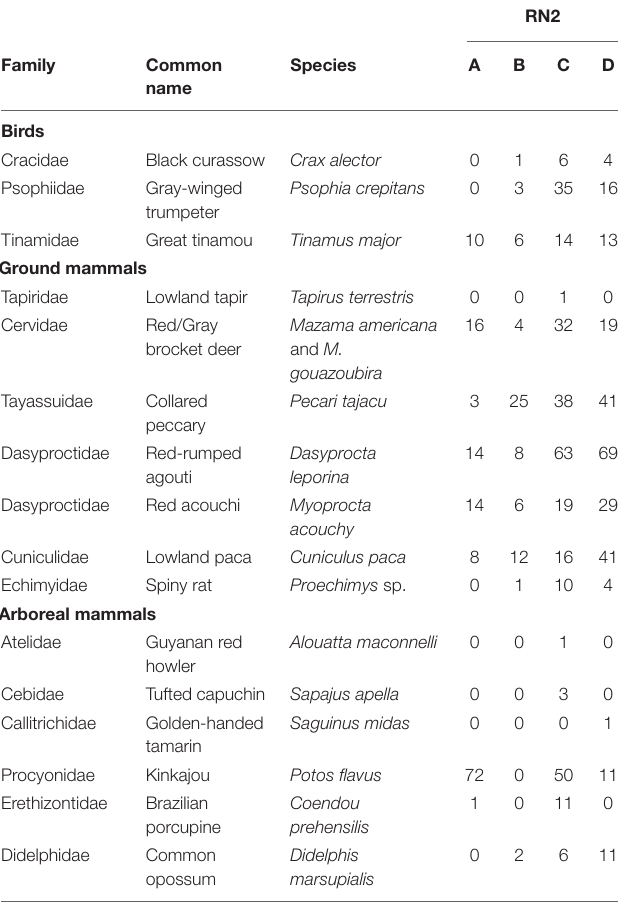
TABLE 3 | Numbers of detection events of frugivorous species recorded near and in Virola and Manilkara trees censused with Reconyx R (cid:13) camera traps at the four forest patches along Road “Nationale 2” (RN2), between Régina and Saint-Georges, French